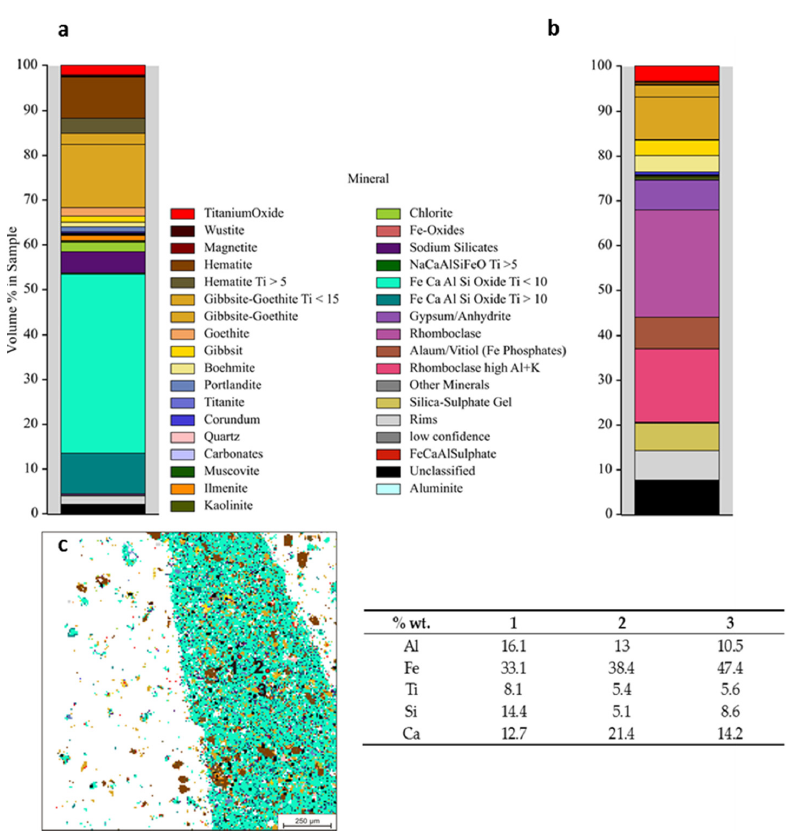
Figure 4. Mineral distribution of red mud: ( a ) and H 2 SO 4 leach residue ( b ) with detailed compositional analyses ( c ) reveled by QEMSCAN and table represents chemical compositions of points labeled as 1, 2 and 3.